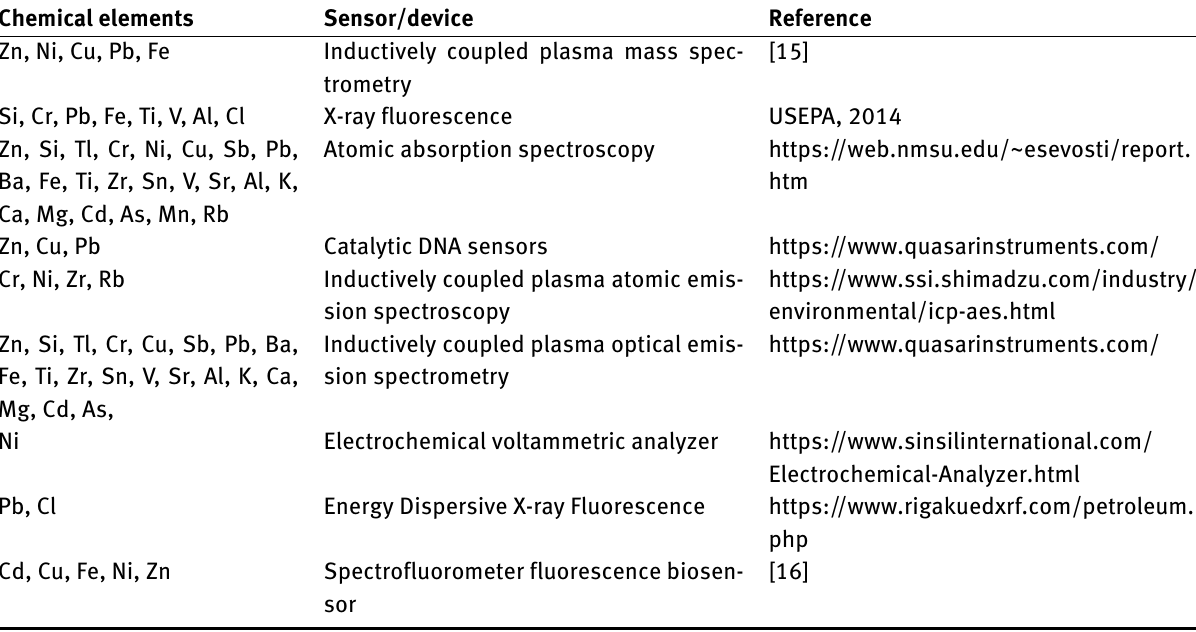
Table 1: Sources, gradation, effects on human health of chemical elements Chemical elements